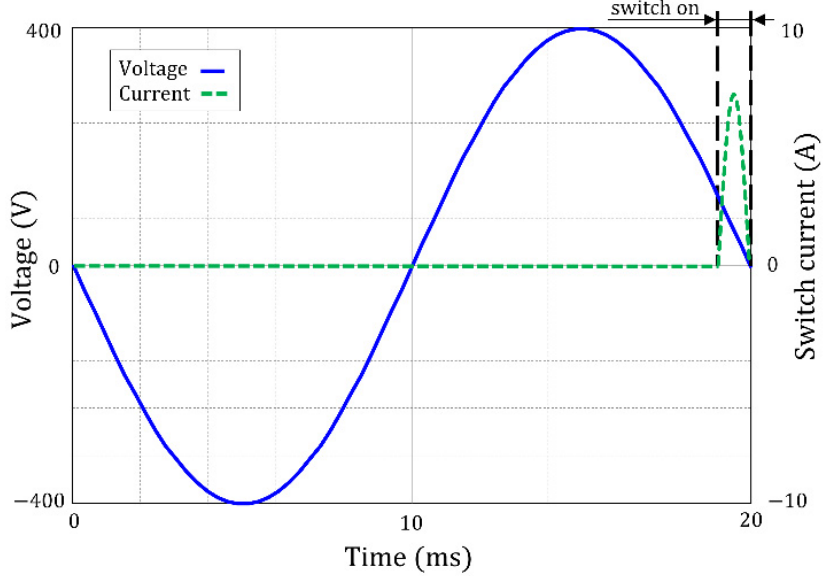
Figure 6. Example of application time (switch on interval) in Change of Impedance method.